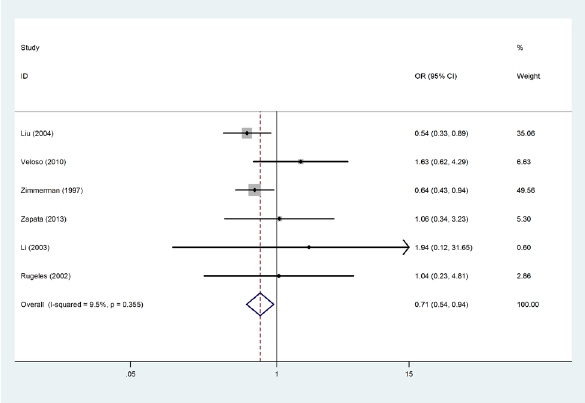
Figure 3: Forest plots demonstrating the association between CCR5-delta32 polymorphism and HIV-1 infection susceptibility in the delta32 homozygote model.